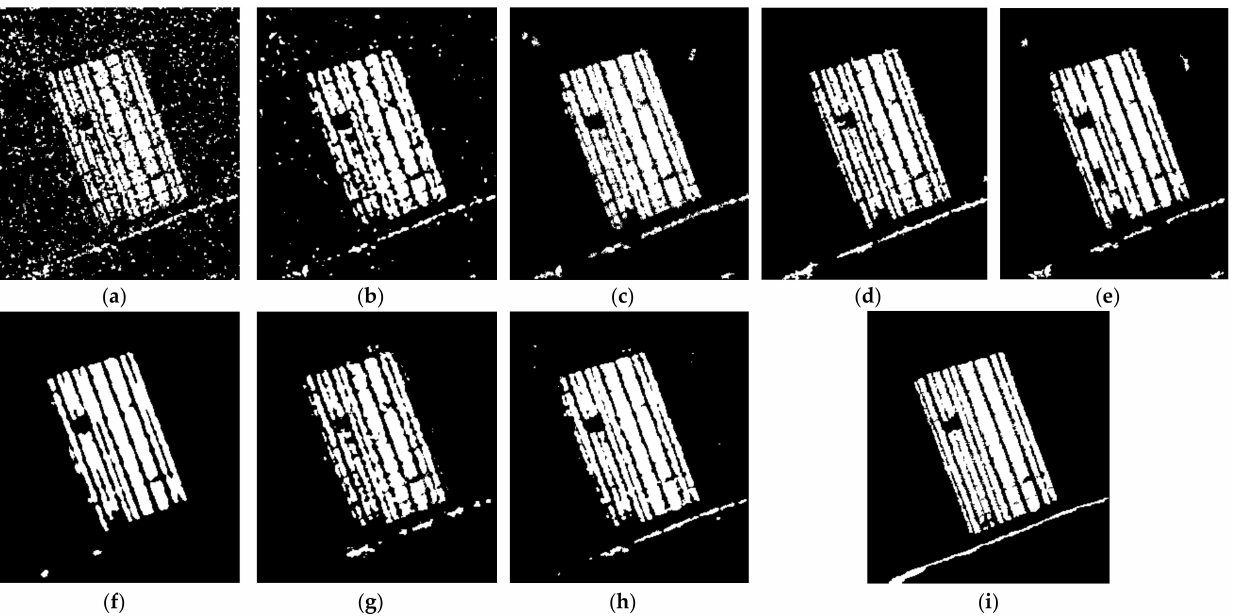
Figure 11. Ground truth and change maps by different methods for the Farmland A dataset.